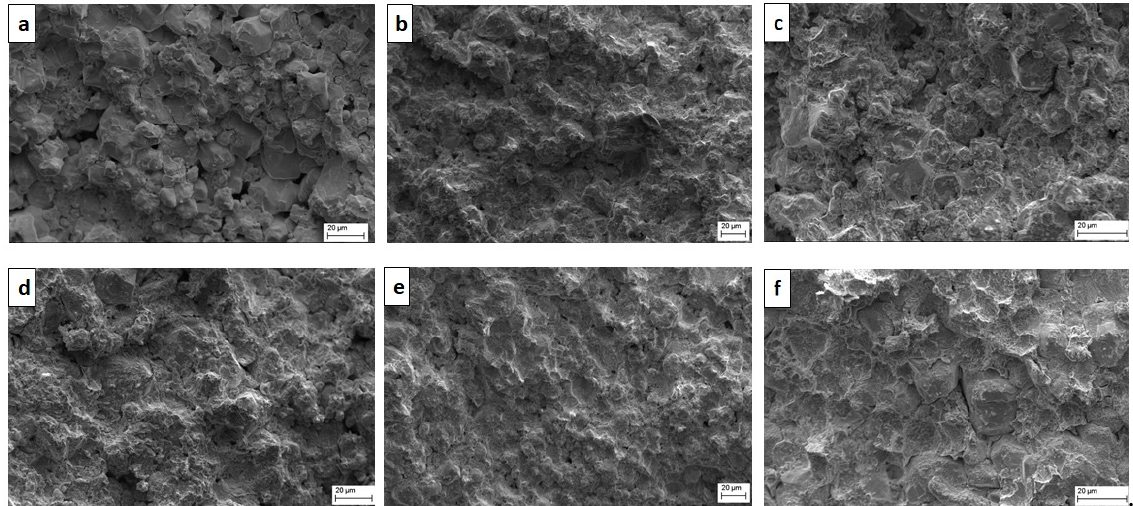
Figure 9. Scanning electron microscope (SEM) images of the fractured surface of samples tested for tensile strength. ( a ) W100%; ( b ) W95%, Cu5%; ( c ) W90%, Cu10%; ( d ) W85%, Cu15%; ( e ) W80%, Cu20%; ( f ) W75%, Cu25%.